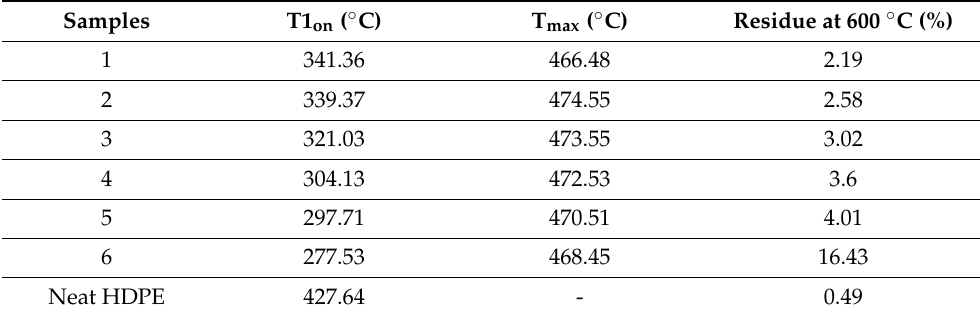
Table 8. TGA results for bamboo–HDPE composites and neat HDPE [85] (modified).